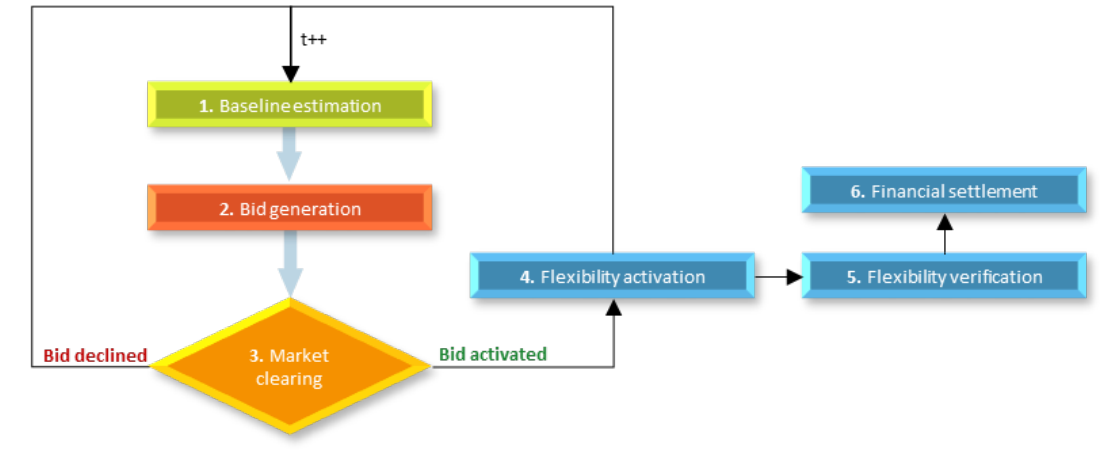
Figure 2. Workflow for flexibility trading.